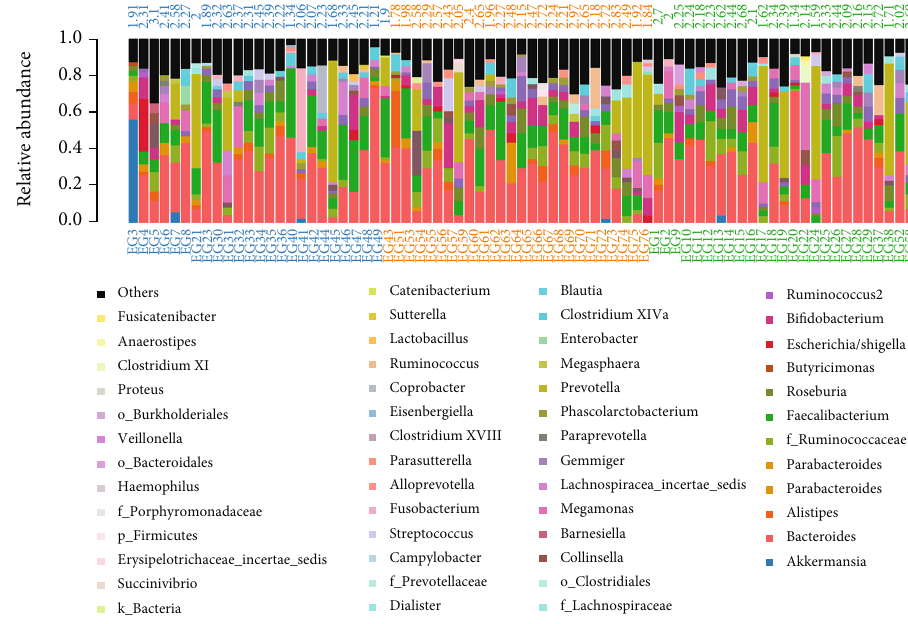
Figure 2: Composition of microbial genera. Composition of fecal microbiota in groups A, B, and C at the genus level. The relative abundance of microbial genera was determined. Each column represents one fecal sample, and the ordinate indicates the relative abundance.